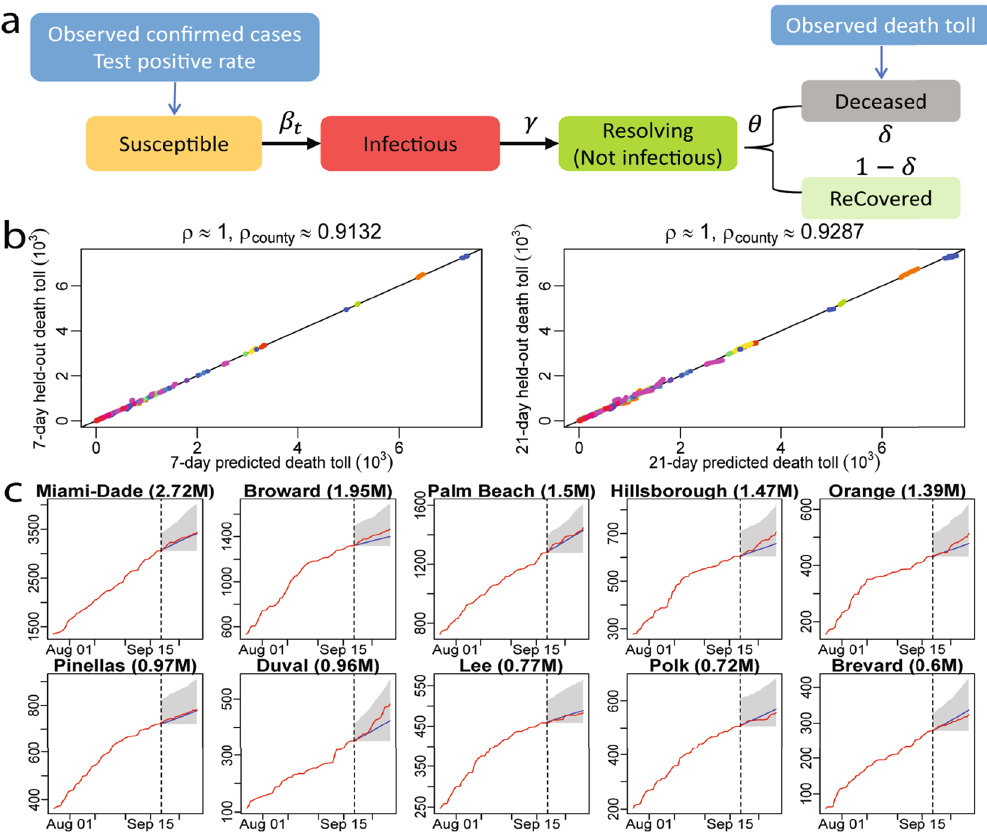
Figure 1. ( a ) The SIRDC model and the data used for analysis. ( b ) 7-day death toll forecast and 21-day death toll forecast against the held-out truth in 2277 US counties with no less than 2 deaths as of 20 September 2020. Each dot is a cumulative death toll for one county at one held-out day. Counties from the same state are graphed using the same color. The Pearson correlation coefficient ( ρ ) of the nation and the weighted average of Pearson correlation coefficient for counties ( ρ county ) are recorded. ( c ) 21-day death toll forecasts in 10 counties with largest population in Florida, where the red line represents the observed death toll and blue line means the forecast. The forecast starts from 21 September 2020, marked by the vertical black dash line. The grey shadow area is the 95 % confidence interval of the forecast. Numbers in the parentheses right after the county name are population in million. The Figs. 2 and 3 show 21-day death toll forecast for all counties in Florida and California.